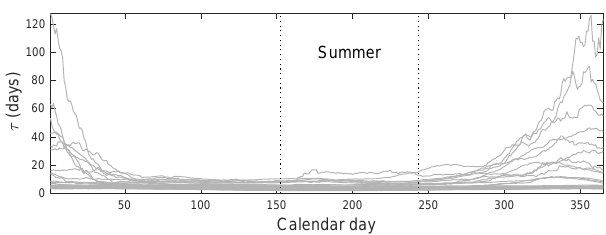
Figure 5. Temporal variation of the residence time ( τ k = k − 1 ) for the 25 catchments. The temporal variation is obtained as in Fig. 4.